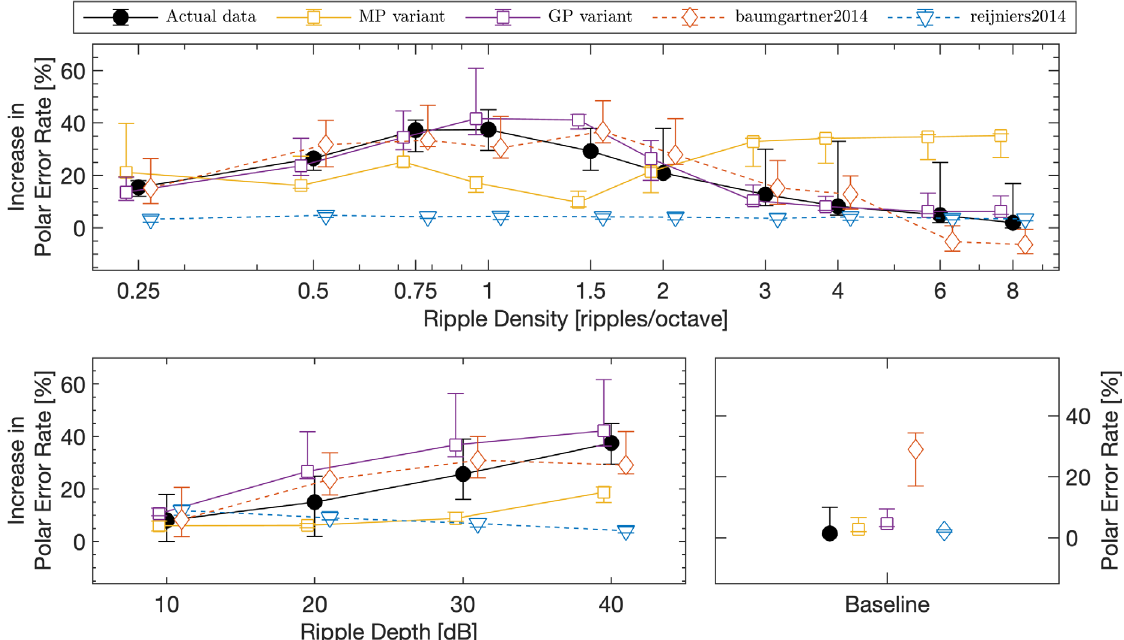
Figure 8. Effect of spectral ripples in the source spectrum on sound localization performance in the median plane. Right-most bottom panel: localization error rates obtained without spectral ripples serving as reference. Top and bottom left panels: Differences to the reference condition shown in the right-most bottom panel. In addition to predictions from the two model variants (MP and GP), predictions from reijniers2014 [6] and baumgartner2014 [15] as well as actual data from [33] ( data_macpherson2003 ) as shown. Note that ripple densities were varied at a fi xed ripple depth of 40 dB and ripple depths were varied at a fi xed ripple density of one ripple per